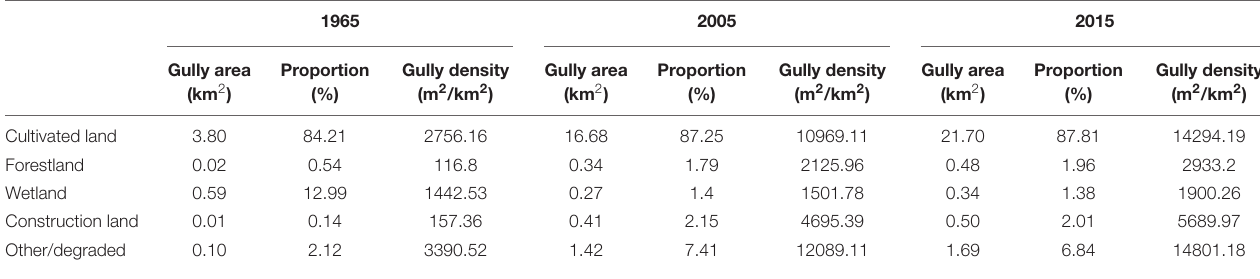
TABLE 4 | Gully erosion conditions in different land use types from 1965 to